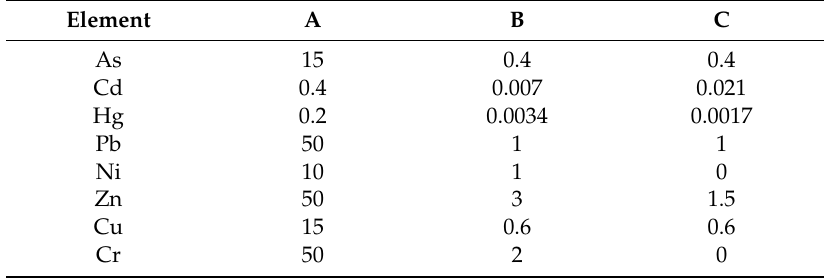
Table 2. Reference values for the SIV calculation of each element, according to the Dutch norm